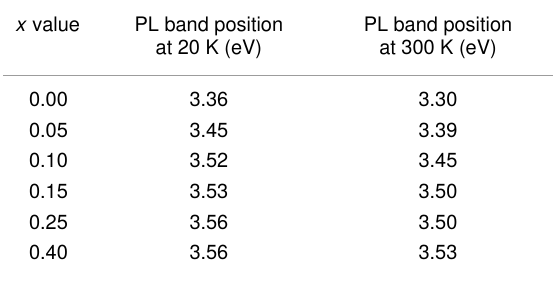
Figure 6: a) XRD pattern of a Zn 0.8 Mg 0.2 O film deposited by spin coating on a Si substrate and annealed at 500 °C. b) XRD pattern of a Zn 0.8 Mg 0.2 O film deposited by spin coating on a glass substrate and annealed at 400 °C.